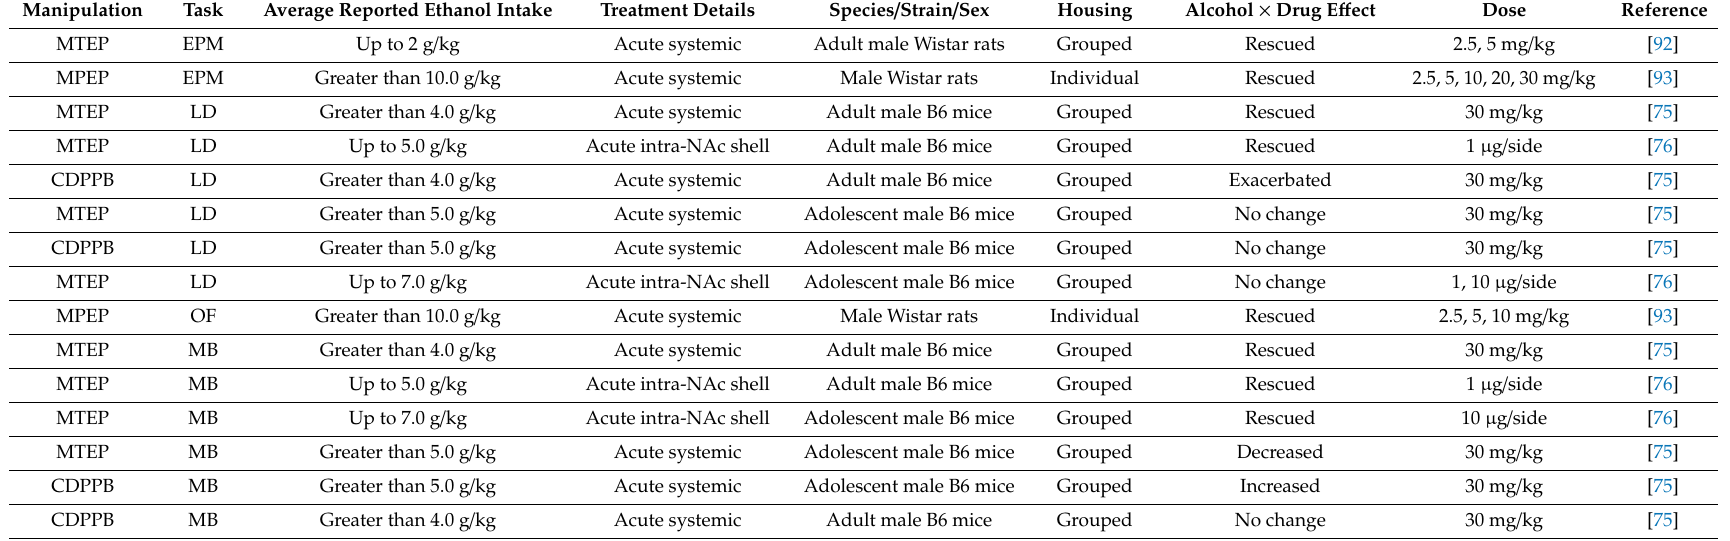
Table 4. Details from studies assessing anxiety-like activity following mGlu5 modulation in the elevated plus maze (EPM), light / dark box (LD), open field (OF), and marble burying (MB)